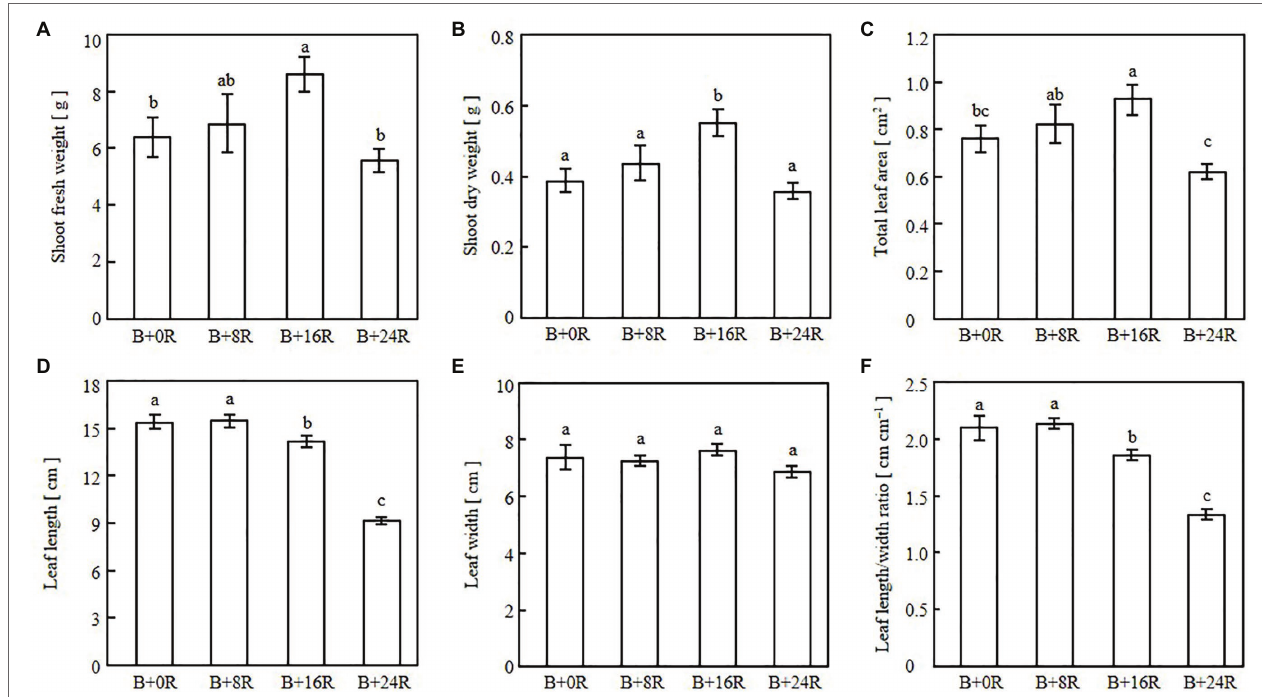
FIGURE 5 | Shoot fresh weight (A) , shoot dry weight (B) , total leaf area (C) , leaf length (D) , leaf width (E) , and leaf length/width ratio (F) of cos lettuce seedlings grown under irradiation conditions described in Figure 1 (Experiment 1). Bars represent SEMs ( n = 8). Different lower-case letters above bars within a panel indicate a significant difference ( p < 0.05, Tukey–Kramer HSD test).